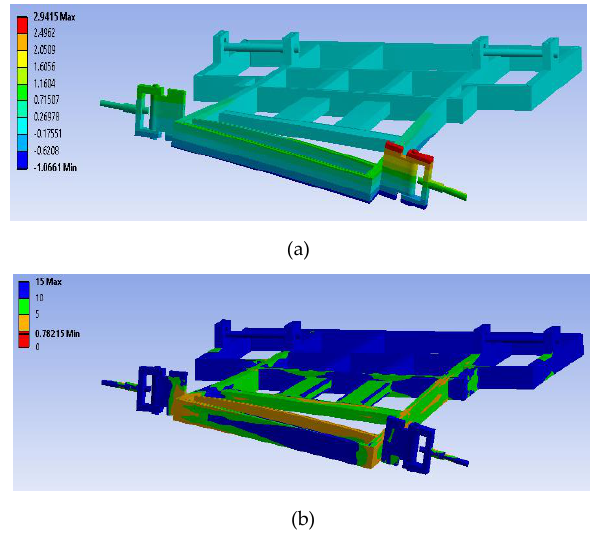
Figure 20: Deformation (a) and safety factor (b) of the ninth varia- tion of chassis simulation